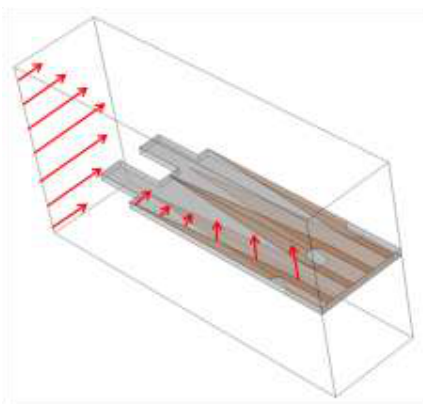
Figure 7: Electric field rotation performed by each FLuS.